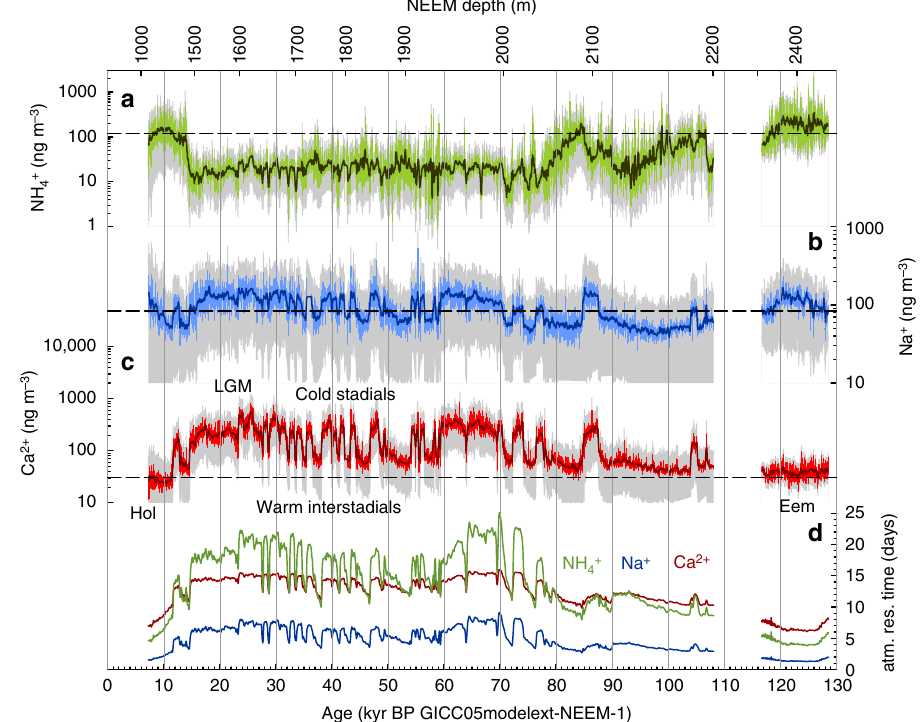
Fig. 2 Reconstructed source concentrations. Variations of the source concentration records in 10 year resolution (light coloured lines) for a NH 4 + , b Na + , and c Ca 2 + (note the smaller logarithmic range of the Na + axis). The dark bold lines represent 21 point running means of the 10 year data. The dashed straight line indicates the early Holocene average. The grey area represents the uncertainty band (1 sigma) as calculated from Gaussian error propagation of the deposition parameters. Note that in the error propagation for the Eemian section only the uncertainty in the past precipitation rate is included, while we assumed that the other deposition parameters in the model were the same for the Eemian and the Holocene and, thus, do not introduce an additional error when comparing Eemian and Holocene values. In panel d the calculated atmospheric residence time for each of the aerosol species is